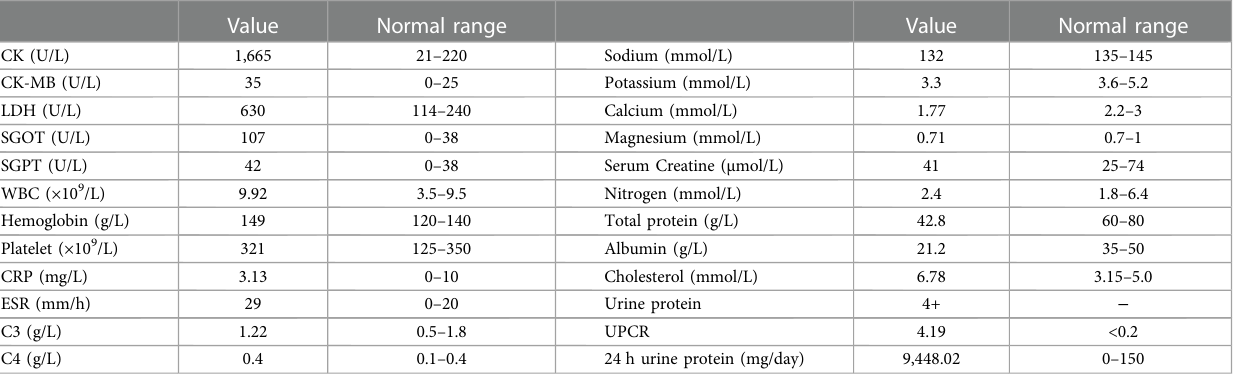
TABLE 1 Laboratory tests at the time of